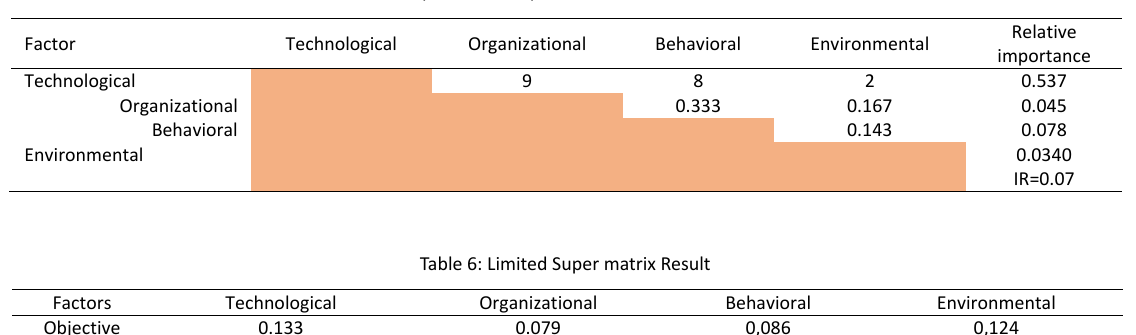
Fig. 4: The main model in the case of significant numbers (t value) Table 5: pairwise comparison matrix of main criteria